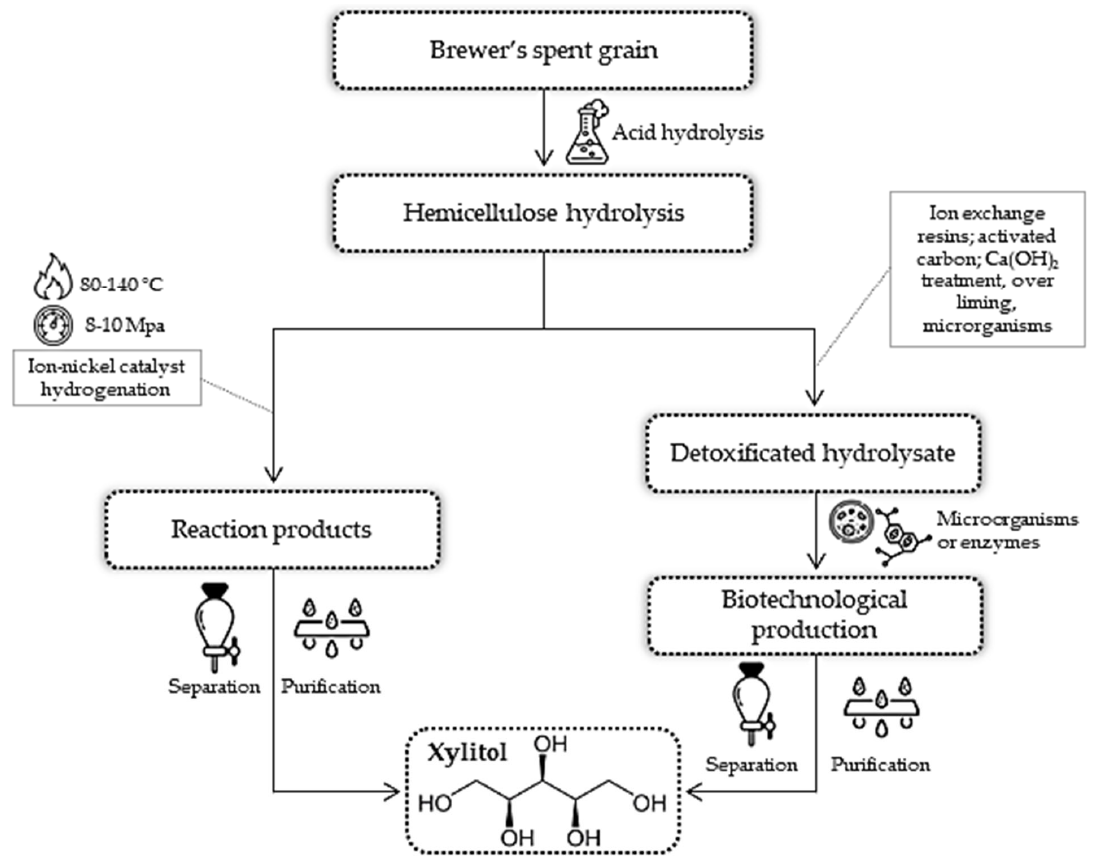
Figure 4. Chemical and biotechnological routes for converting hemicellulose to xylitol. Many microorganisms can use xylose as a carbon source and convert it into xylitol, generally mediated by enzymatic catalysis by xylose reductase (XR). Xylitol production is obtained by reducing xylose to xylitol as the first step of xylose metabolism with NAD(P)H- dependent XR. Yeasts are the preferred biocatalysts for this process due to high rates of pentose assimilation in some species and stable levels of XR expression, resulting in high xylitol yields [77]. Candida guilliermondii [78,79], Debaryomyces hansenii [80], Komagataella pastoris [81], and Pachysolen tannophilus [55] are some of the yeasts used in research to obtain xylitol from BSG hemicelluloses efficiently.